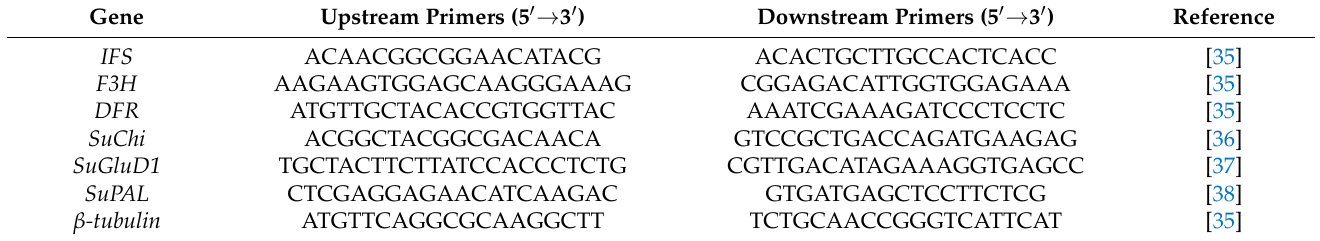
Table 2. Primers for qRT–PCR.